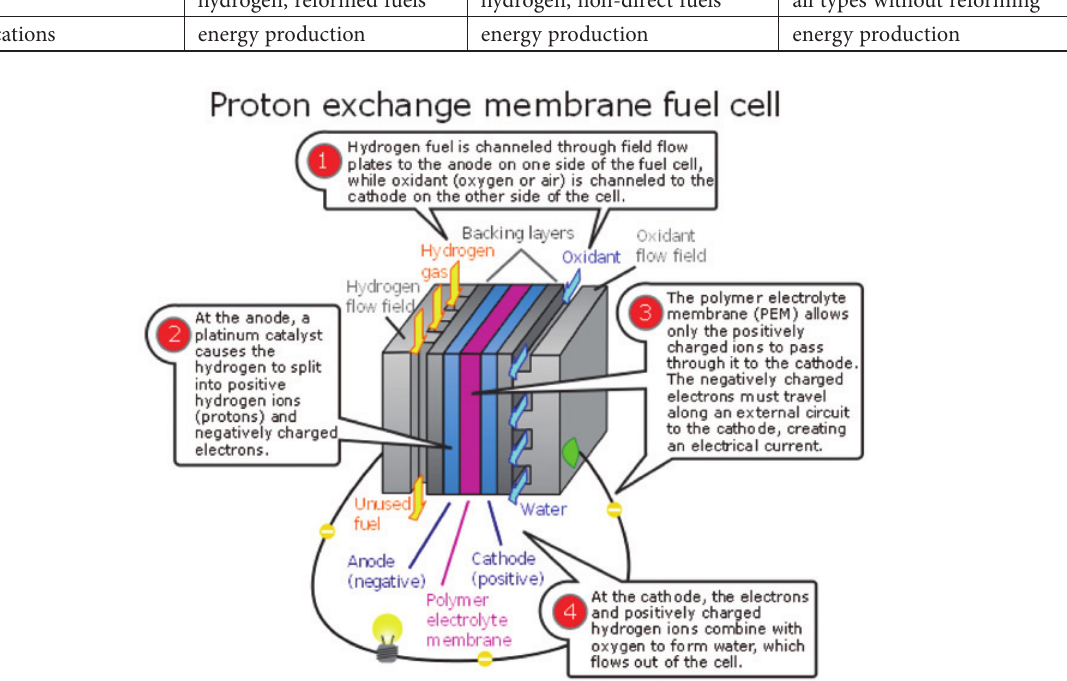
Fig. 1. Principle of PEM fuel